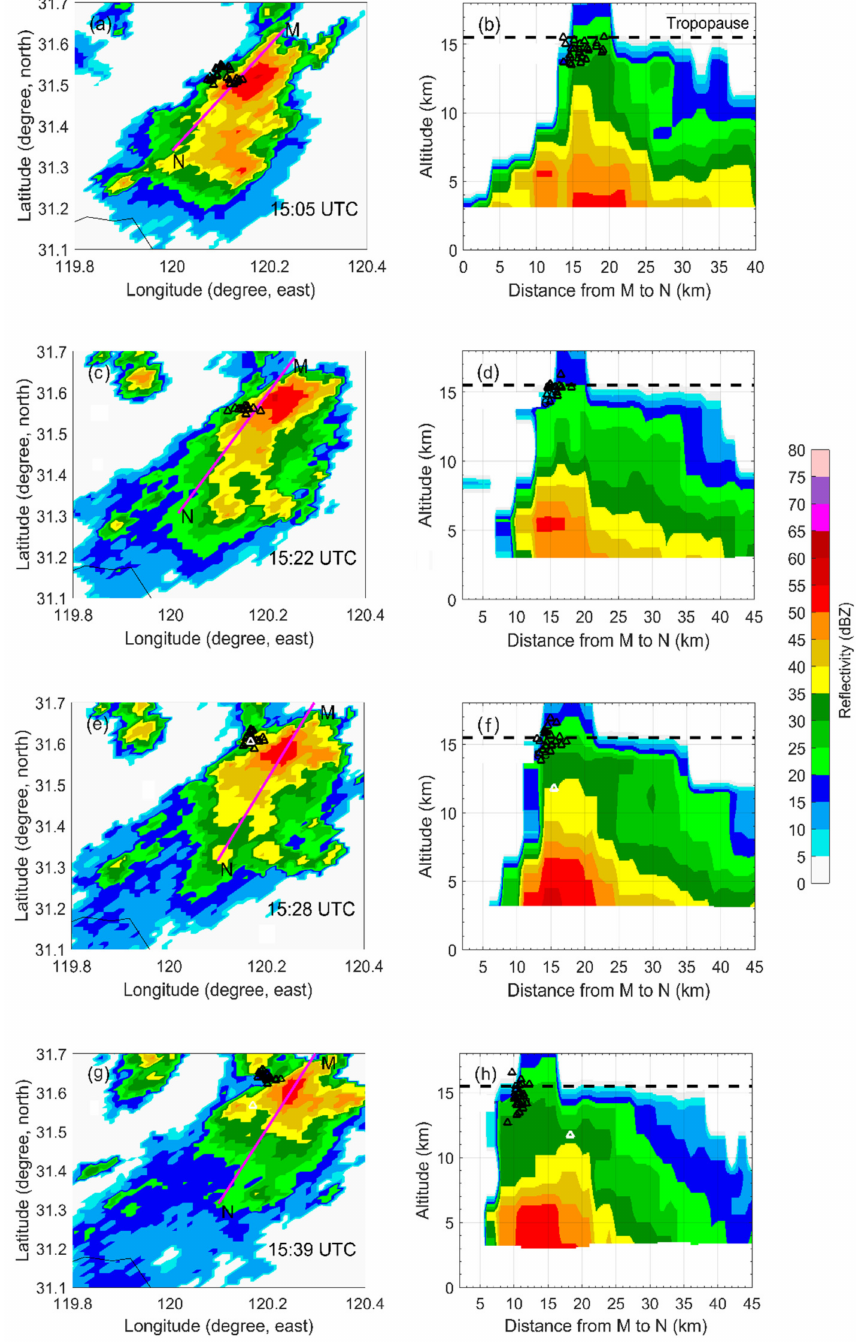
Figure 4. Locations of NBEs overlapped on the radar reflectivity in the Taihu thunderstorm. Black and white triangles represent the negative and positive NBEs, respectively. ( a , c , e , g ) Locations of negative NBEs overlapped on the composed PPI radar echo at 1505 UTC in case Hangzhou Bay. ( b , d , f , h ) Vertical profile of radar reflectivity along the path MN from PPI radar